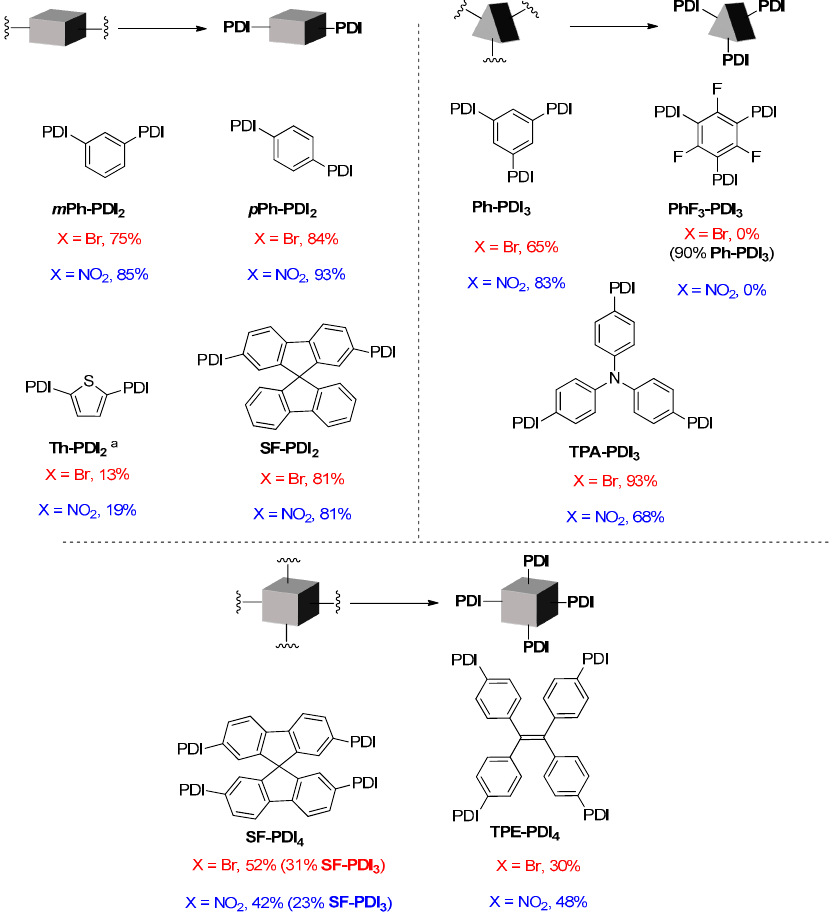
Figure 2. Schematic structures of PDI-based multimers obtained through SMC from 1-nitroPDI 5 and 1-bromoPDI 3 . Figure adapted with permission from reference 57. Copyright (2019) John Wiley and Sons.